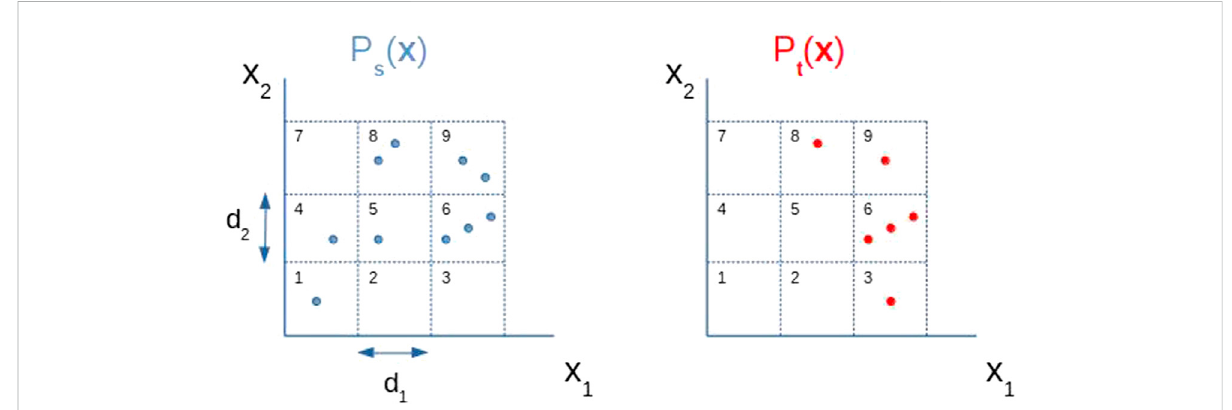
FIGURE 5 (cid:13)(cid:13)(cid:13)(cid:13) (cid:16) Discretizationofatwodimensionalrandomvariable x =( x 1 , x 2 ).Thevaluesofdiscretizationsteps d 1 and d 2 determinethesizeofeachrectangle. p s p t , where p i is a probability of x belonging to rectangle i (i.e. p t 3 (cid:2) Now, B ( P s , P t ) (cid:2) − ln (cid:1) 9 i (cid:2) 1 i i